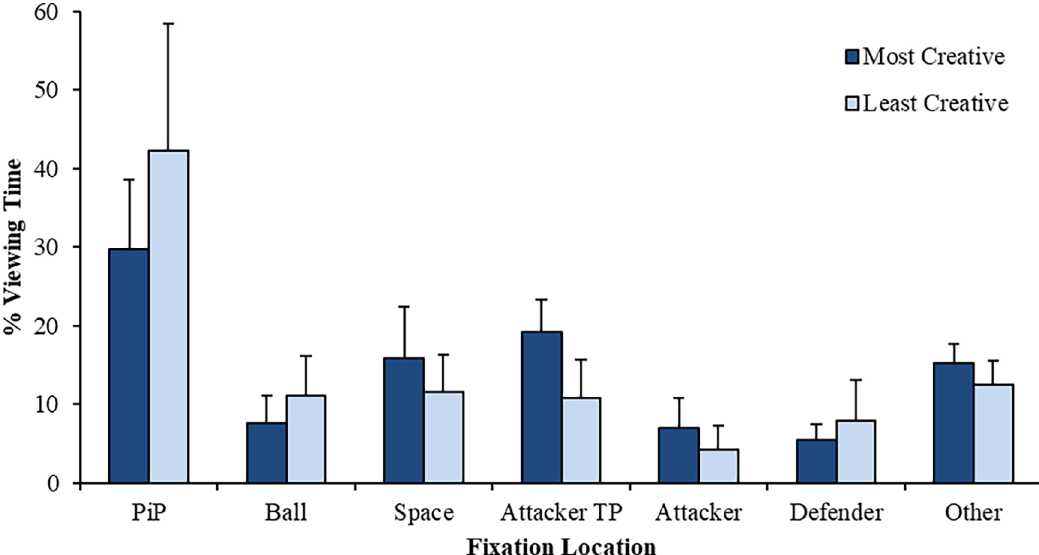
Fig 1. Mean (SD) percentage of time spent viewing each fixation location across groups ( PiP , player in possession of the ball; Attacker TP , attacker in a threatening